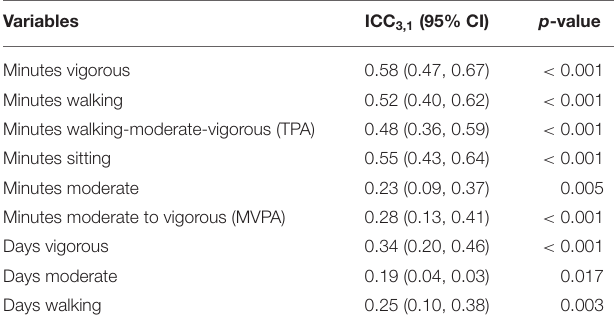
TABLE 4 | ICC table for reliability of the mIPAQ-SF between 8- and 12-month follow-up.